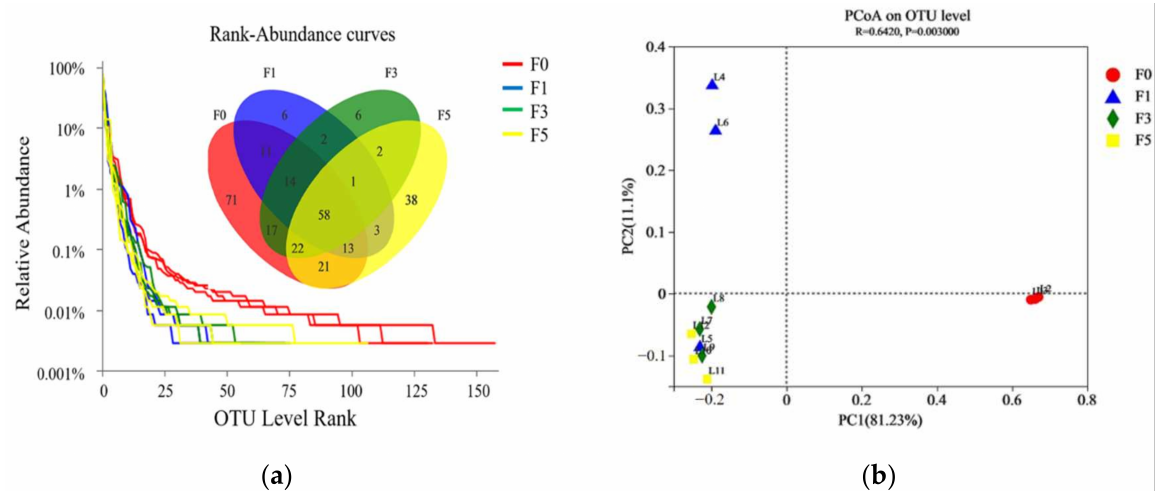
Figure 1. The rank-abundance curves were derived from the microbial OTU level. ( a ) The Venn graph illustrates the overlap of microbial OTUs among the treatment groups F0, F1, F3, and F5 at a 3% dissimilarity level; ( b ) PCoA analysis of taxonomical classifications in groups F0, F1, F3, and F5. Each group has three replicates. Group F0 contains L1, L2, and L3. Group F1 contains L4, L5, and L6. Group F3 contains L7, L8, and L9. Group F5 contains L10, L11, and L12.